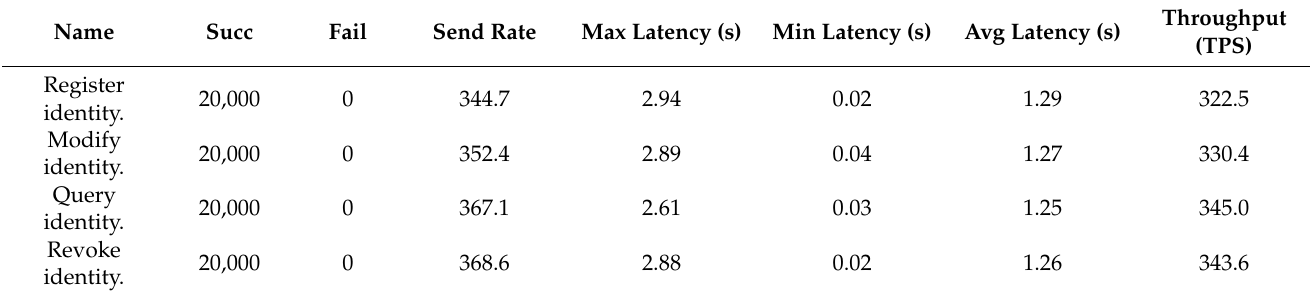
Table 7. Caliper report of Fabric performance under multiple virtual machines.